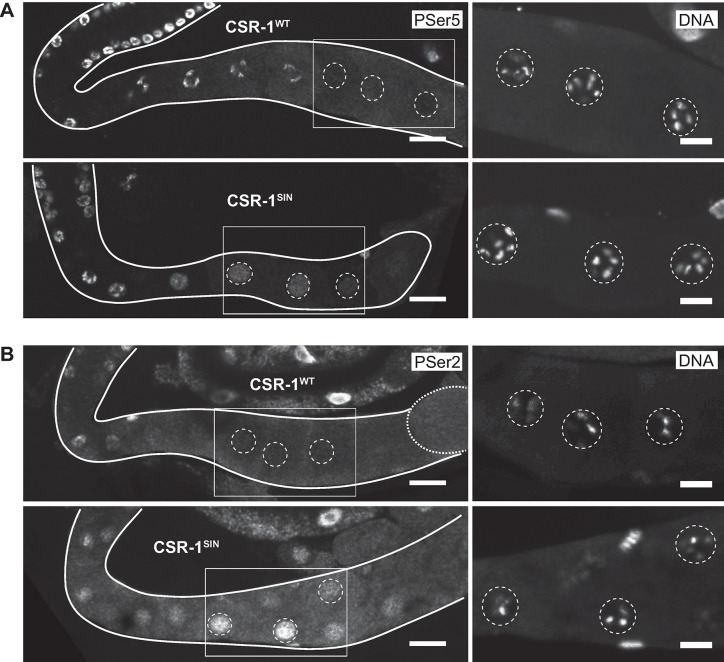
The slicing activity of CSR-1 is required for Pol II inhibition.(A) Fluorescent confocal micrographs showing gonads from csr-1(tm892) animals expressing either CSR-1WT or CSR-1SIN. On the left, the gonads were immunostained for phosphorylated serine 5 (PSer5) within the C-terminal domain of RNA-Polymerase II, indicating transcriptional initiation. Notice the oocyte staining in CSR-1SIN (but not CSR-1WT) -expressing gonads. Scale bars: 20 μm. The boxed areas are magnified on the right, showing the same gonads stained for DNA by DAPI, to visualize the highly compacted chromosomes characteristic of arrested oocytes. The dotted lines encircle oocyte nuclei. Scale bars: 10 μm. (B) Median intensity projections of confocal micrographs showing gonads immunostained for the serine 2 phosphorylation of Pol II CTD (PSer2), which indicates transcriptional elongation. Notice the oocyte staining in the CSR-1SIN (but not CSR-1WT) -expressing gonad. Scale bars: 20 μm. The boxed areas are magnified on the right, as in A. Scale bars: 10 μm.